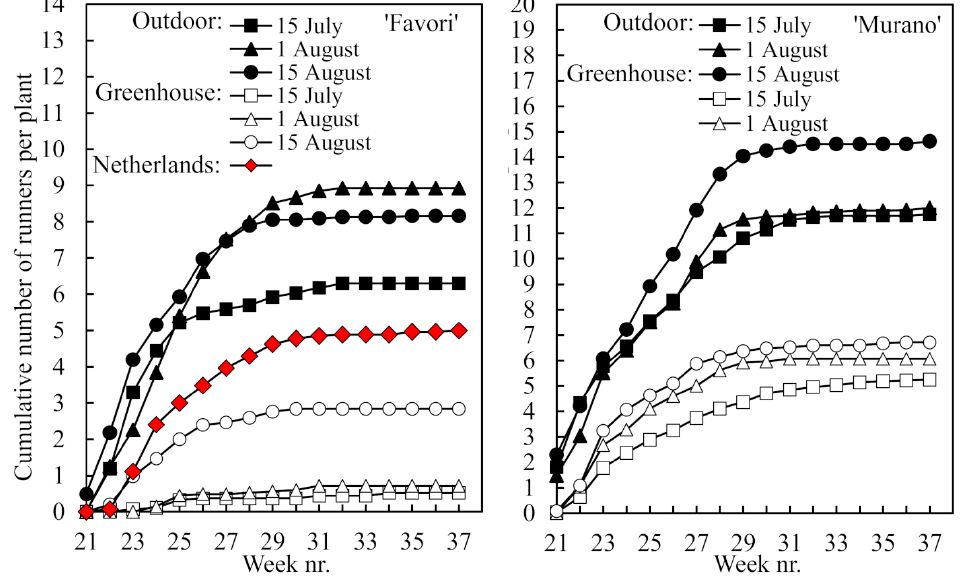
Figure 5. Time courses of cumulative runner formation during the cropping season in two everbearing strawberry cultivars as affected by rooting date and raising environment in the previous season. Results for imported ‘Favori’ plants included for comparison. The data are means of three replicates with nine plants of each cultivar. Note the different scales for the